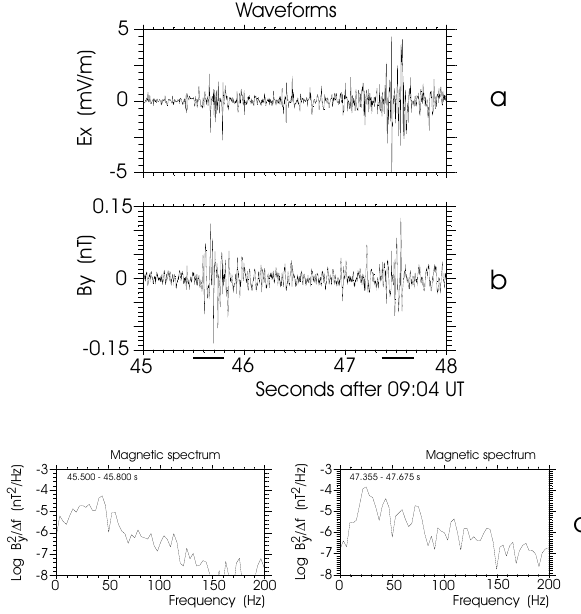
Fig. 2. Illustration of the wave data recorded during the occurrence of two well-defined electromagnetic bursts: (a) Waveform of the E x electric field component, (b) Waveform of the B y magnetic compo- nent, (c) Magnetic spectra showing well defined maxima at ∼ 40Hz and at ∼